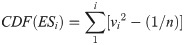
Selection of significant DE genes from CD ΔF(NS).Genes are selected based on their contribution to overall DE provided their variance is not too high. Each gene with DE value (vi) is assigned an enrichment score ESi defined as ESi = |vi2| − (1/n). To assess a gene’s contribution, genes are sorted in descending order of ESi and then assigned a positional rank “i”, ranging from 1 to n, the total number of genes. The “blue line” represents the early portion of a plot of the cumulative distribution function CDF(ESi)=∑1i[vi2−(1/n)] (Eq 6 in Methods), versus “fractional rank” (i/n). This type of plot allows identification of the maximum value of the CDF (green line) and a fractional rank of (imax). At (imax), the gene’s |vi2| ≃ (1/n), the value expected for a vector where all genes make equal contributions. All genes with higher positional ranks than “imax” can thus be excluded on the basis that their |vi2| is less than (1/n) (or ESi ≤ 0) and their contribution to overall DE is minor. To account for the uncertainty of the DEvalue the standard deviation (SD) is included. i.e., 2*SD2 of each gene’s DE value is added to its CDF(ESi) value (“red dots”) (Eq 7 in Methods). For illustration purposes, only every 40th point is shown. The genes with red dots below the green line have a sufficiently high DE value and sufficiently low SD to be included in the significant DE genes in terms of induced fructose effects.